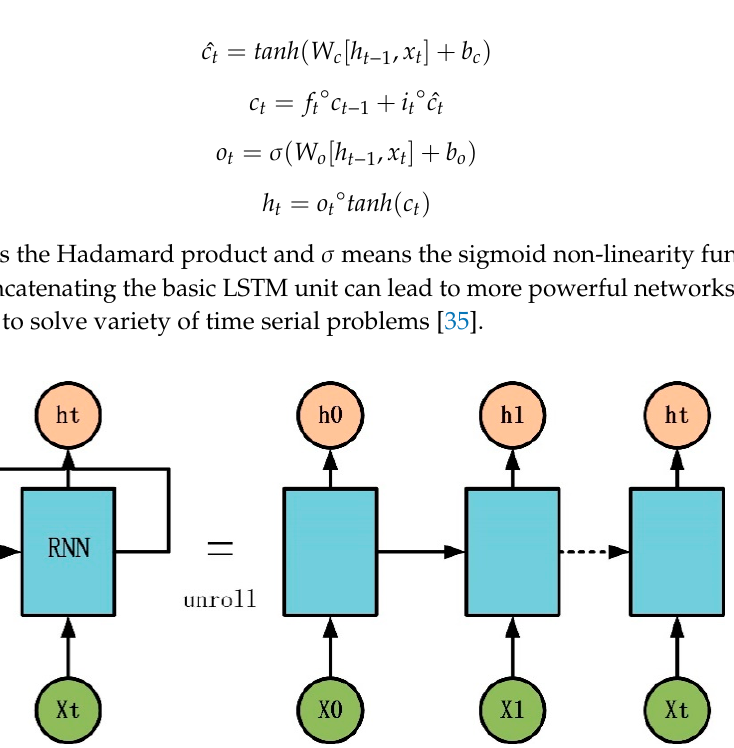
Remote Sens. 2020 , 12 , x FOR PEER REVIEW Figure 2. Unrolled recurrent neural network. RNN—recurrent neural network. Figure 2. Unrolled recurrent neural network. RNN—recurrent neural network.